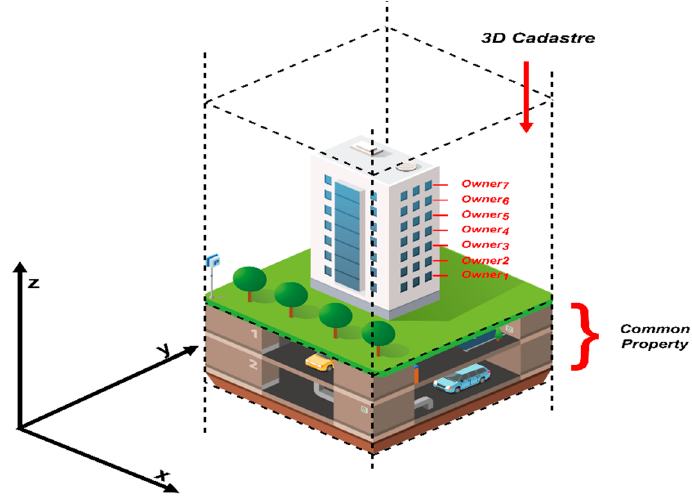
Figure 1. Illustrates the 3D property